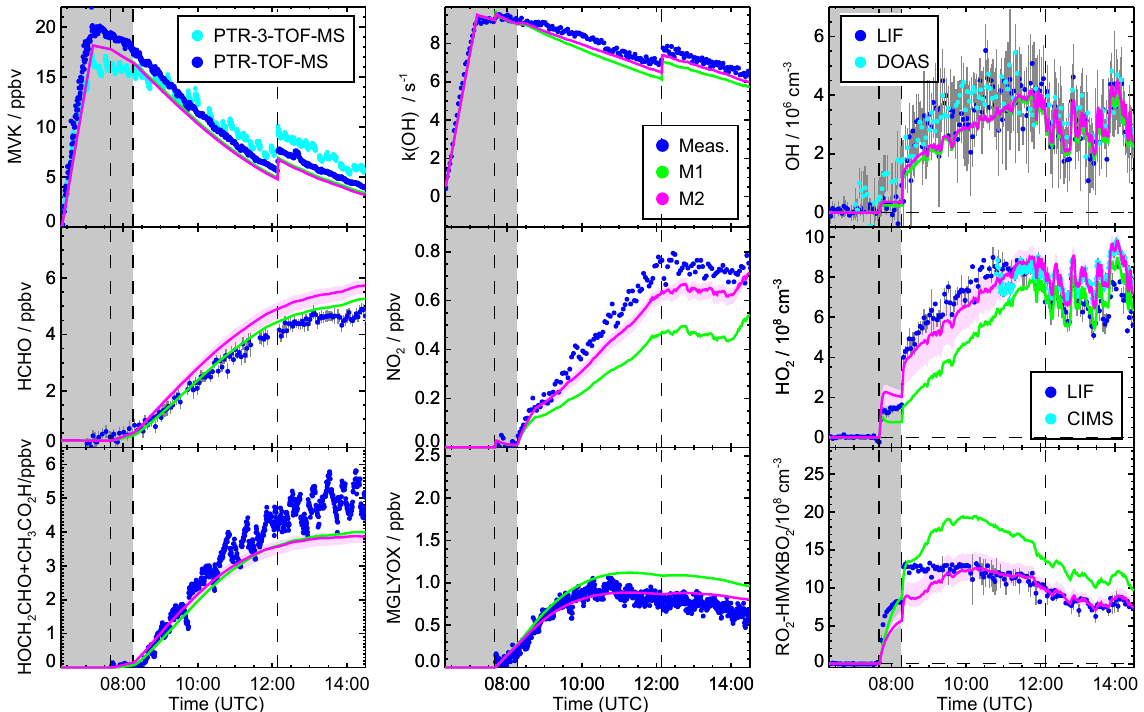
Figure 4. Time series of radicals, inorganic and organic species during the MVK photooxidation at low NO (experiment on 23 May 2017). Dark shaded areas indicate the time before opening the chamber roof and vertical dashed line times when trace gases were injected into the chamber. Model sensitivity runs M1 and M2 include modifications listed in Table